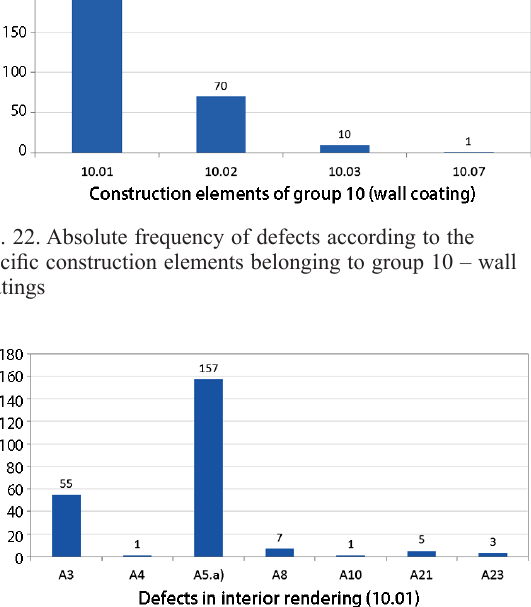
Fig. 23. Absolute frequency of defects in interior rendering